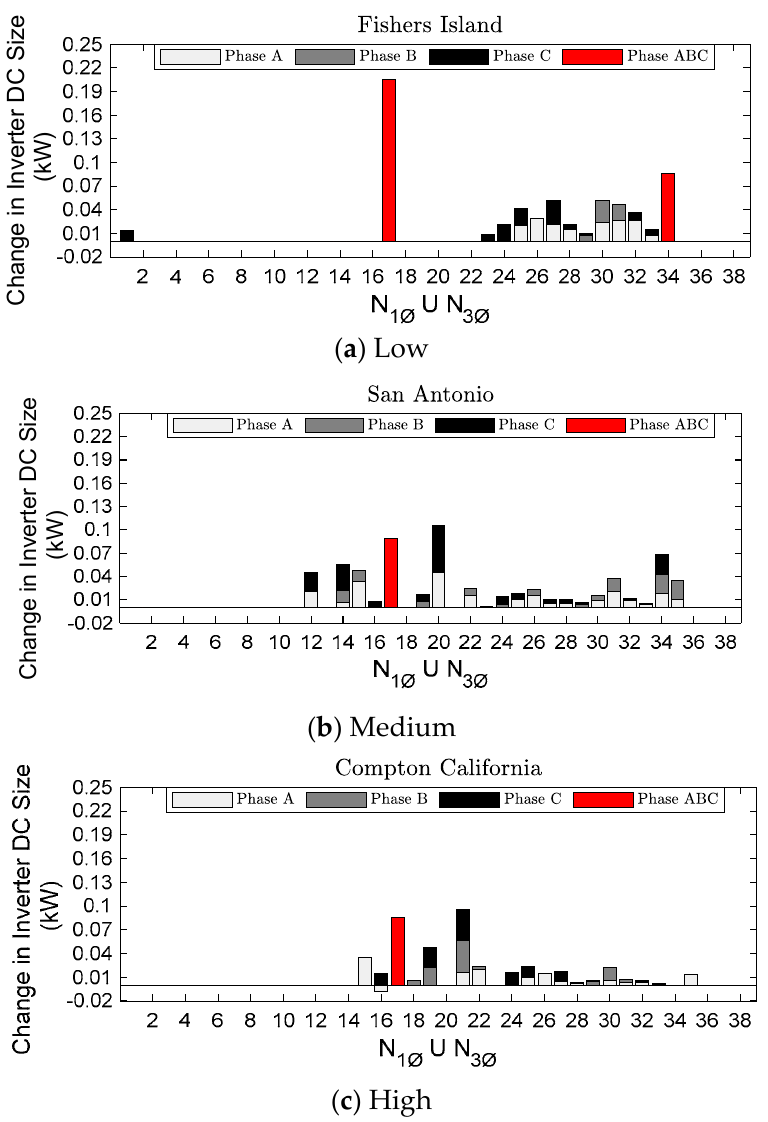
Figure 8. PV inverter placement and size with a load change of +40% in region 1 and +10% in region 2. Figure 10 indicates the maximum and minimum voltage index maintained